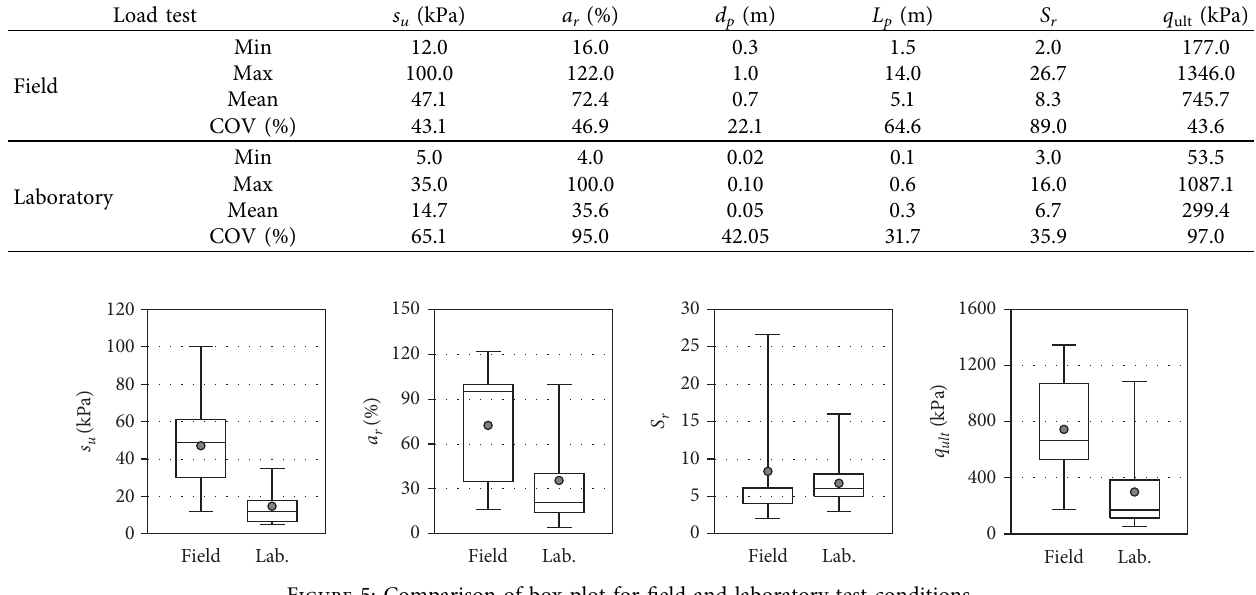
Table 1: Range of feld and laboratory load test conditions.